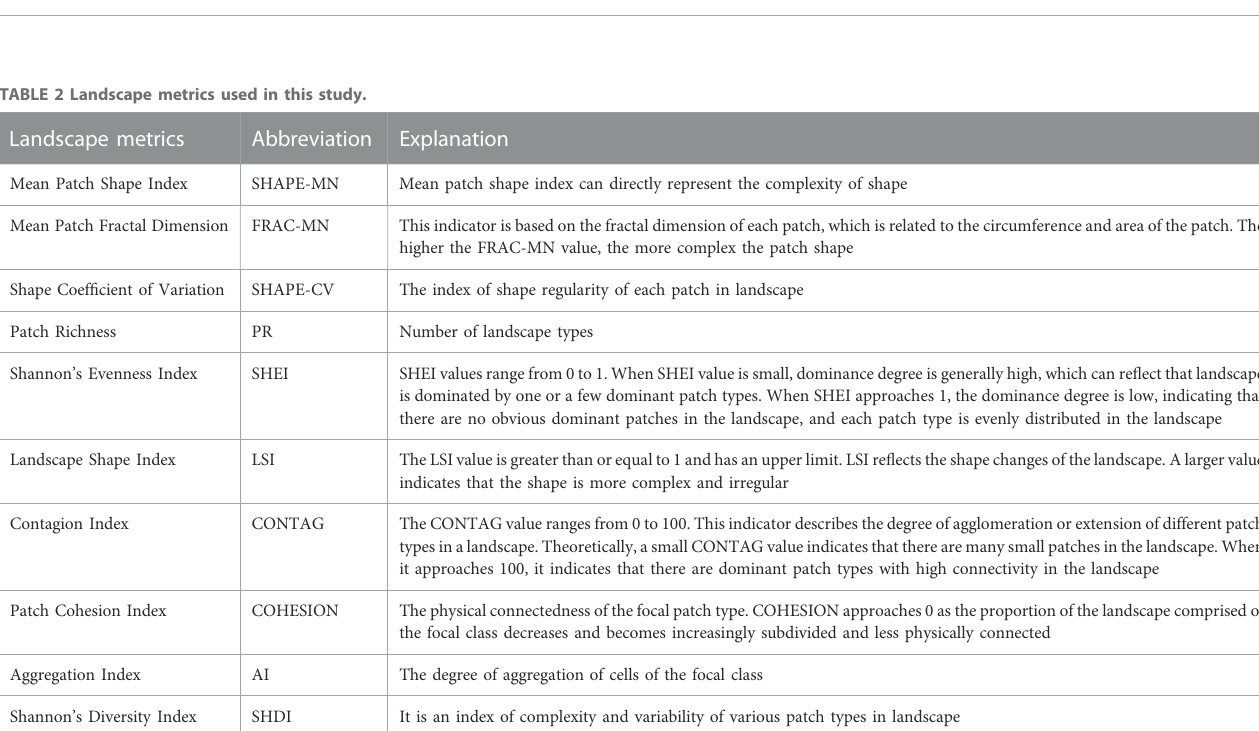
FIGURE 2 Technology roadmap of this study.